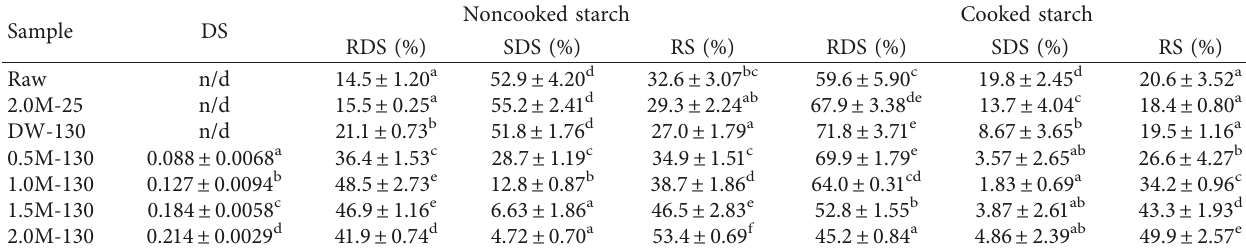
Table 1: Degree of substitution and in vitro digestibility of raw and malic acid-treated sweet potato starches. Noncooked starch Cooked Sample DS